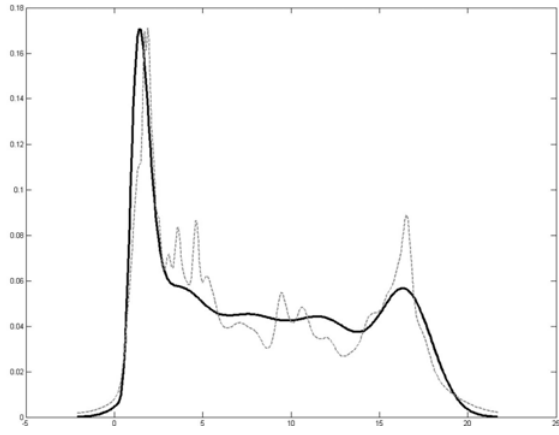
Fig. 7. Reference PDF (solid line) and estimated one (dotted line) through vector quantization based Parzen with K = 300 and h =